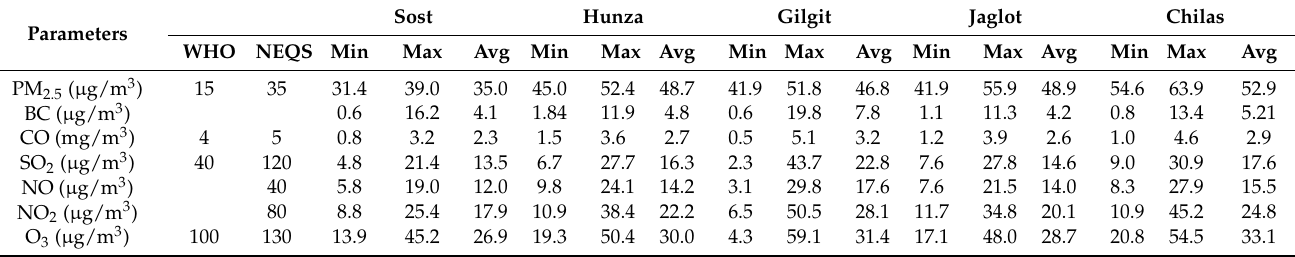
Table 3. Concentrations of selected air pollutants in GB cities during summer,